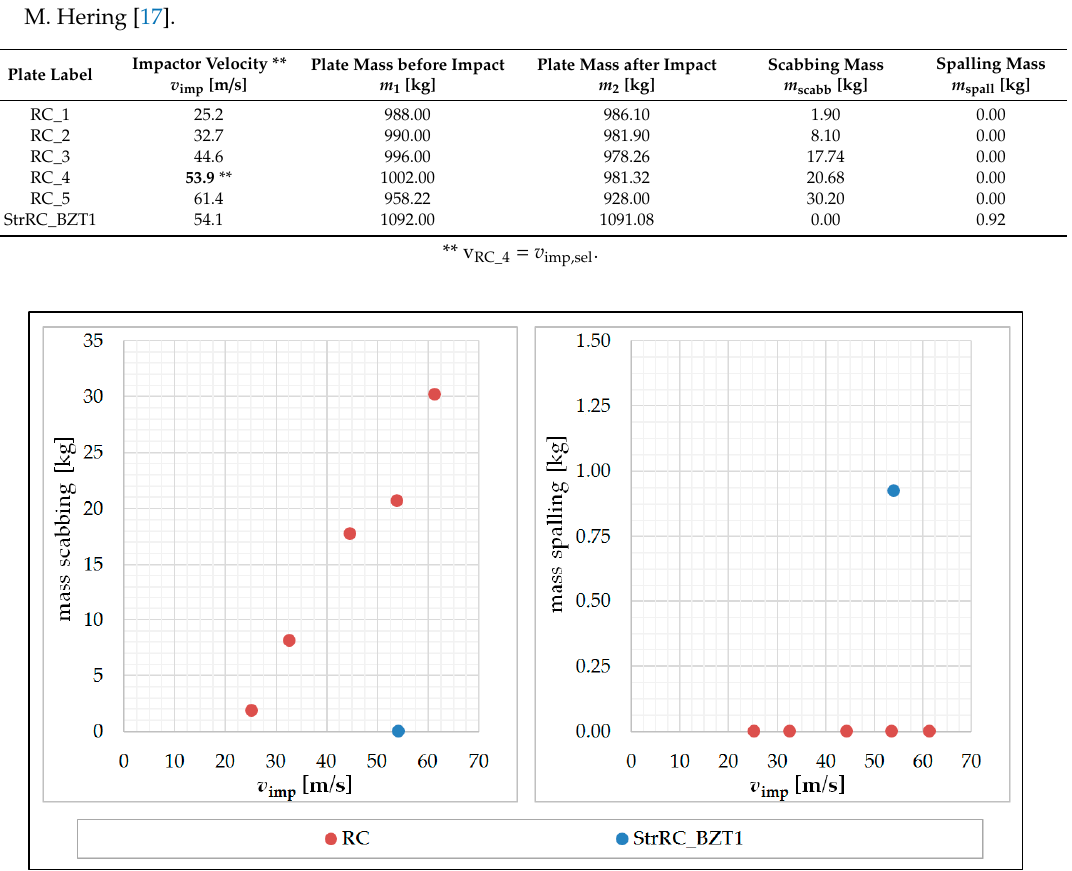
Figure 7. Scabbing ( left ) and spalling masses ( right ) of the reference plates RC_1–5 and the strengthened plate StrRC_BZT1 after impact; graphic: M. Hering. Table 3. Masses of the plates before and after the experiment and masses of scabbing/spalling failure; M. Hering [17].